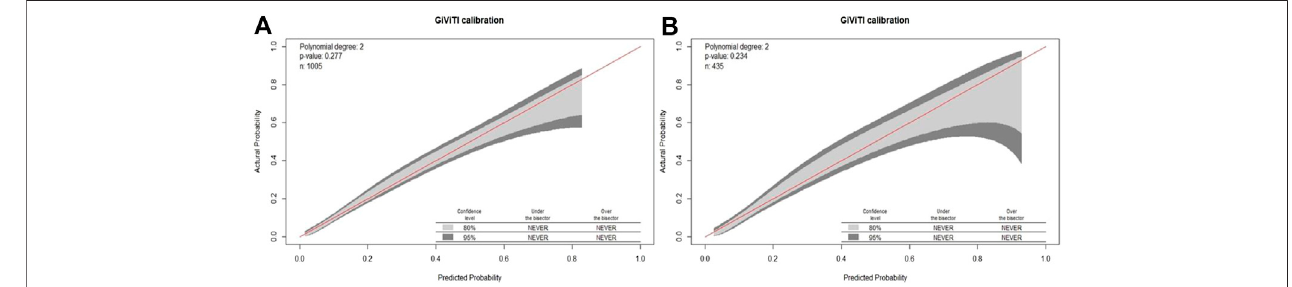
FIGURE 4 | The GiViTI calibration belt in the development (A) and validation (B) groups.